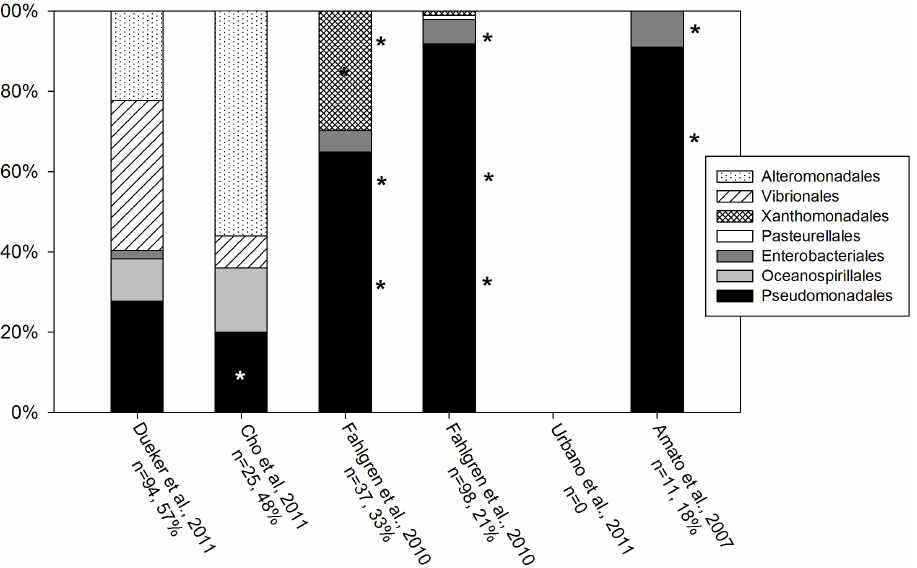
Fig. 4. Classification of Gammaproteobacteria presence in sequence libraries from our data (coastal Maine, USA) and GenBank-published data from marine/coastal/cloud studies from Fig. 3. Number of sequences ( n ), and percent of total library that the Gammaproteobacteria accounted for noted. Classifications assigned using RDP’s Naive Bayesian rRNA Classifier (80% threshold) Version 2.2, March 2010. An asterisk (*) indicates significant differences in phylum-level community structure from this study as per RDP’s Library Compare Tool, p < 0 . 01. An asterisk outside a bar indicates that the library is significantly missing an order (asterisk placed at same height as this study’s order